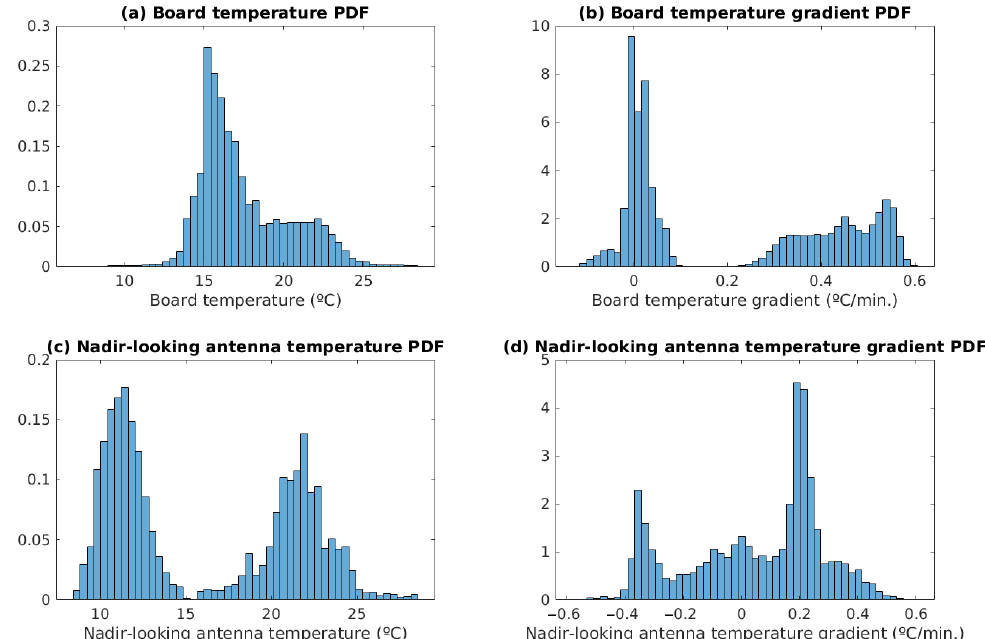
Figure 1. ( a ) Temperature probability density function (PDF) of the instrument board during execu- tions, ( b ) 1-minute integrated temperature gradient of the instrument board, ( c ) Temperature PDF of the nadir-looking antenna during executions ( d ) 1-minute integrated temperature gradient of the nadir—looking antenna.